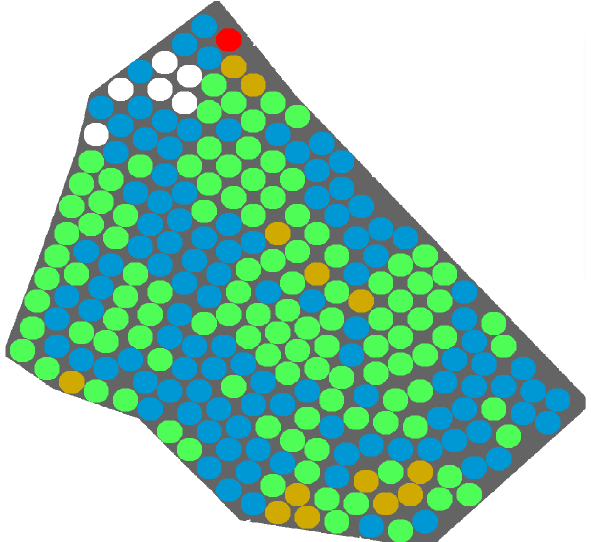
Figure 18: Densities of fuel types in circular areas with 10m radius of near-surface fuel.